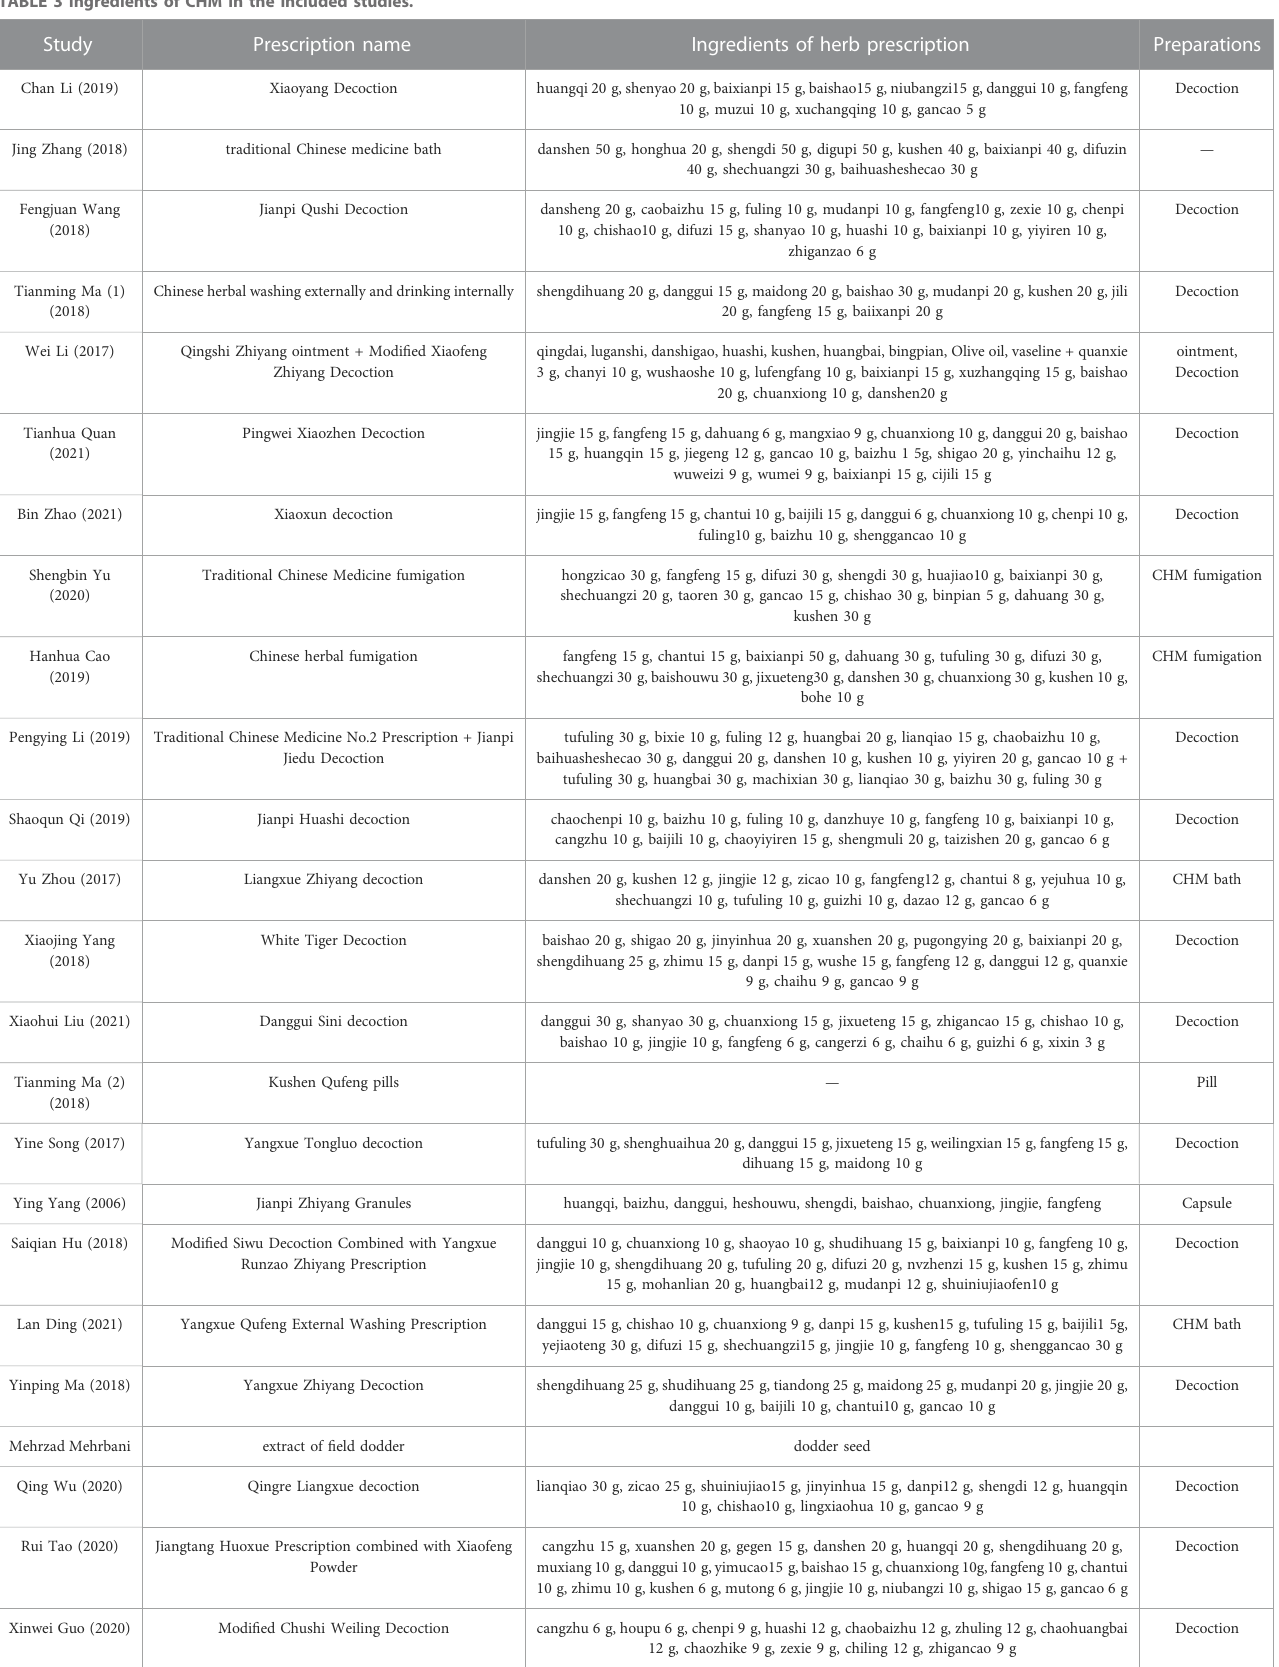
TABLE 3 Ingredients of CHM in the included